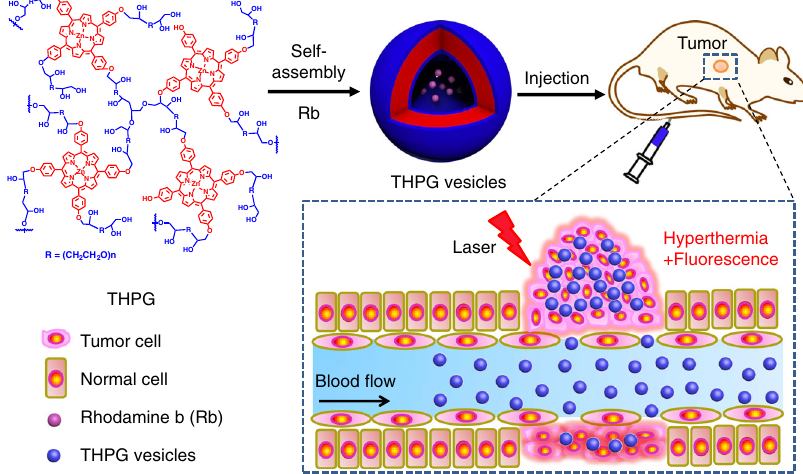
Fig. 1 A schematic diagram of hyperbranched polyporphyrin vesicles for photothermal therapy. Nano-sized polymer vesicles from the self-assembly of hyperbranched polyporphyrins show effective photothermal killing of tumors in